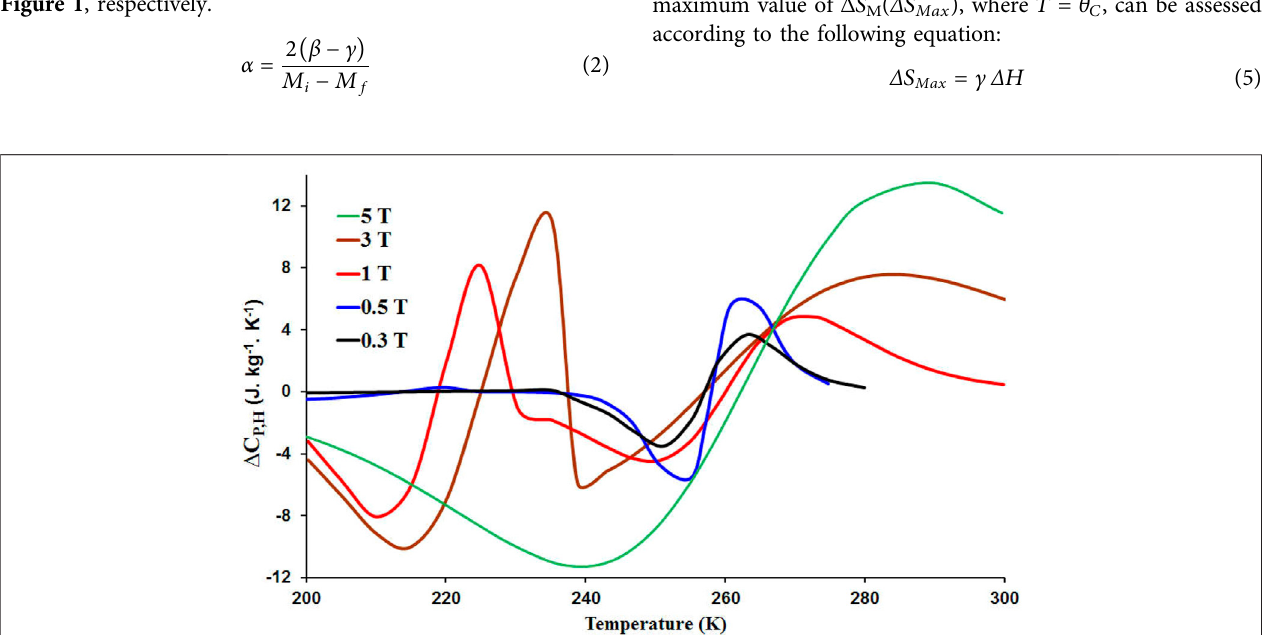
Frontiers in Materials |